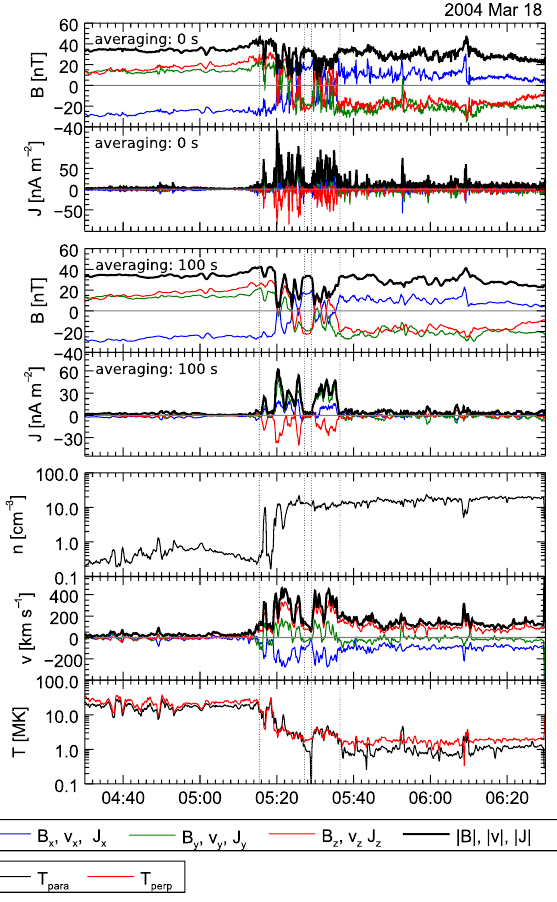
Figure 5. Outbound magnetopause crossing through the entry layer region on 18 March 2004. The upper and middle panels show the magnetic field and the curlometer result in GSE coordinates with spin resolution data and after application of a 100s averaging win- dow, respectively. The lower panel shows CIS hot ion particle den- sity n , velocity v , and temperature T . A complete magnetopause transition between 05:16 and 05:27UT and a second contact with the transition layer between 05:29 and 05:36UT are visible. Both are accompanied by accelerated plasma bursts and a distortion of the magnetic field. The curlometer results shows a series of en- counters with similarly orientated current layers across the transi- tion